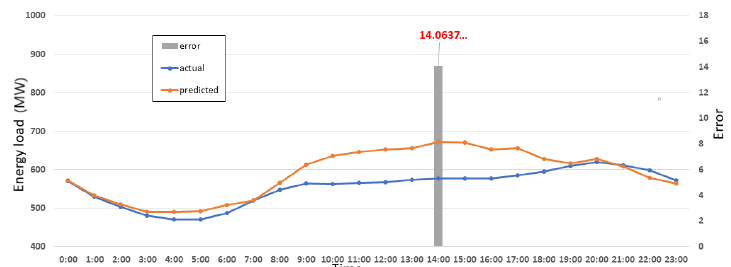
Figure 16. Comparison of actual and predicted energy with error on Chuseok Day in South Korea.